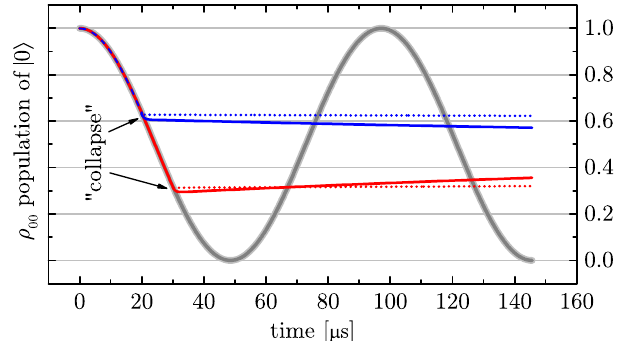
. According to the RF